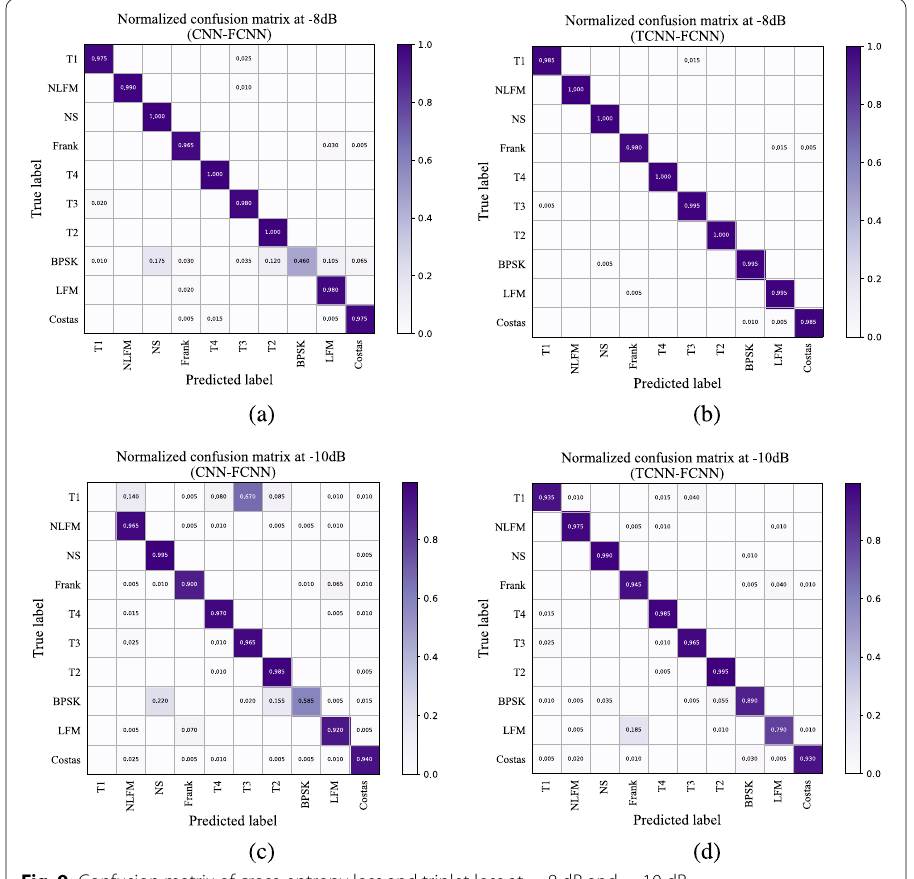
Fig. 9 Confusion matrix of cross-entropy loss and triplet loss at